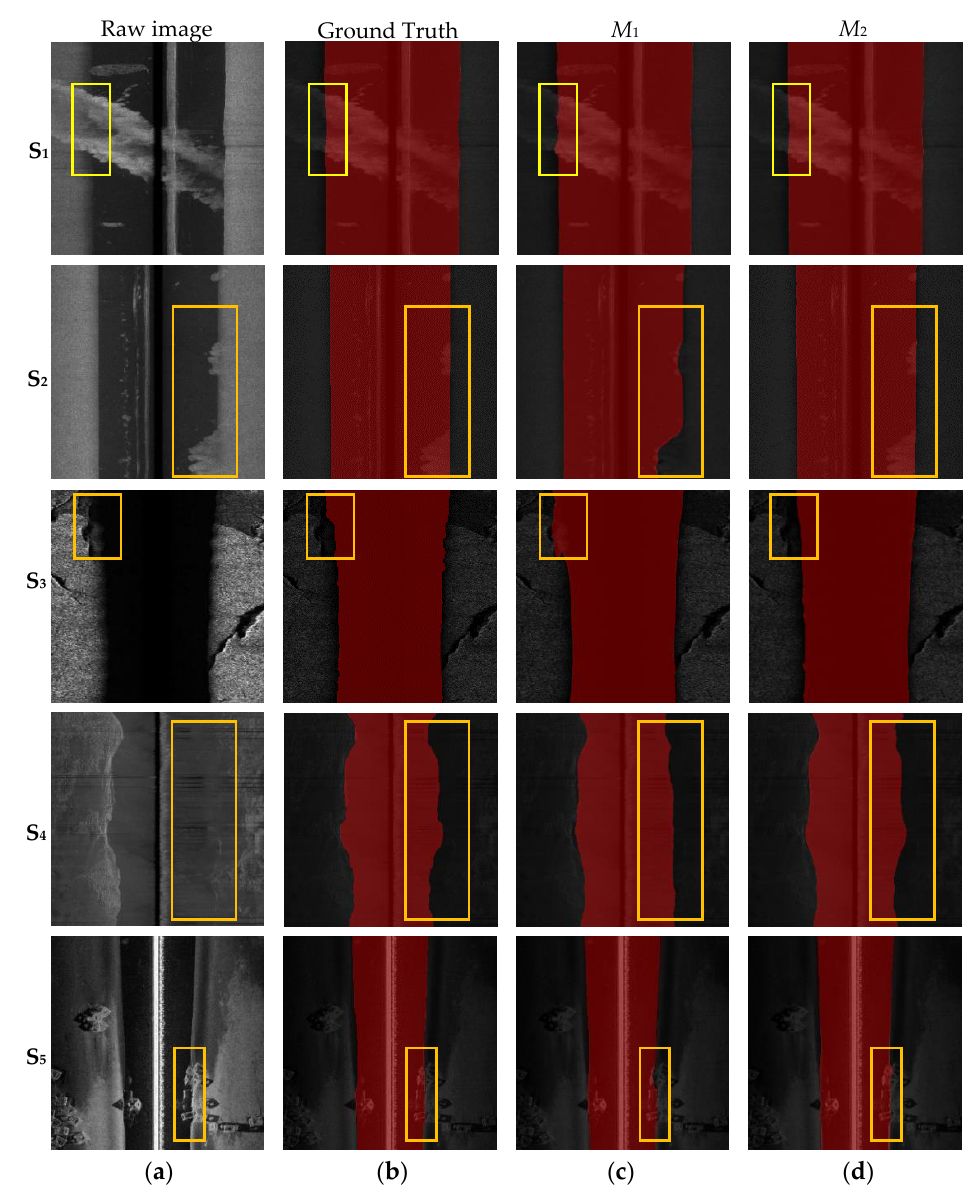
Figure 11. Segmentation performances of different trained models. ( a ) Original SSS image blocks with a size of 513 × 513 pixels. ( b ) Ground truth by manual labeling. ( c ) Segmentation results with M 1 . ( d ) Segmentation results with M 2 .